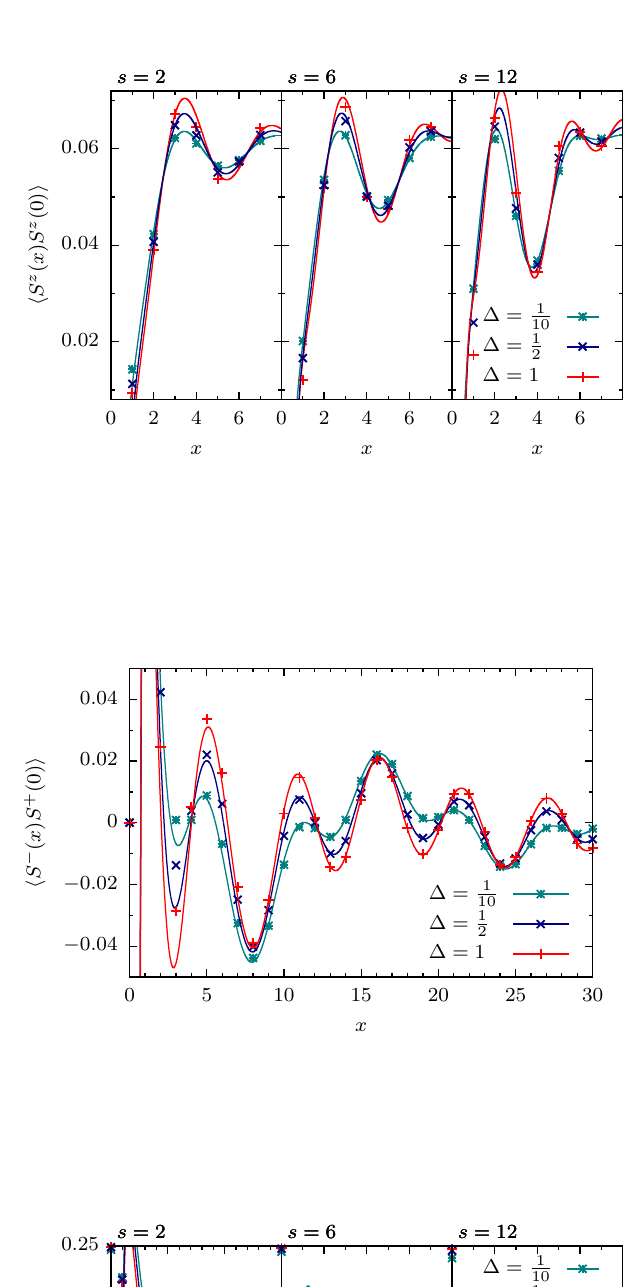
Figure 10: Transverse static real space correlation 〈 S − ( x ) S + ( 0 ) 〉 for very short distances, at N = 200, M = 50 for several values of the anisotropy, for states with a mo- mentum split in the Fermi sea by s = 2,6,12 (from left to right pan- els respectively). The figure com- pares the ABACUS results (points) to the multi-component Tomonaga- 6 Luttinger model